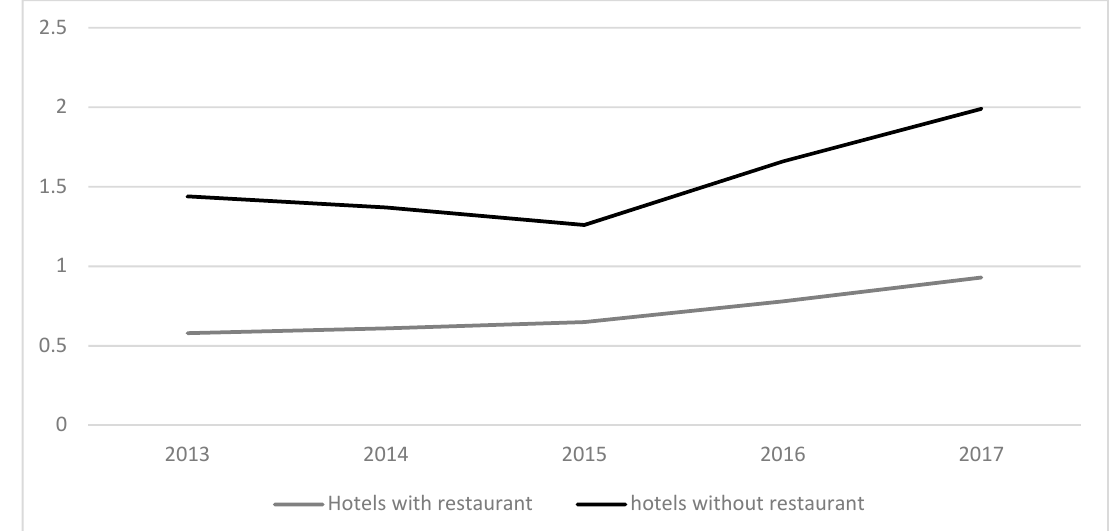
Figure 5 . Current Ratio, with and without a restaurant.